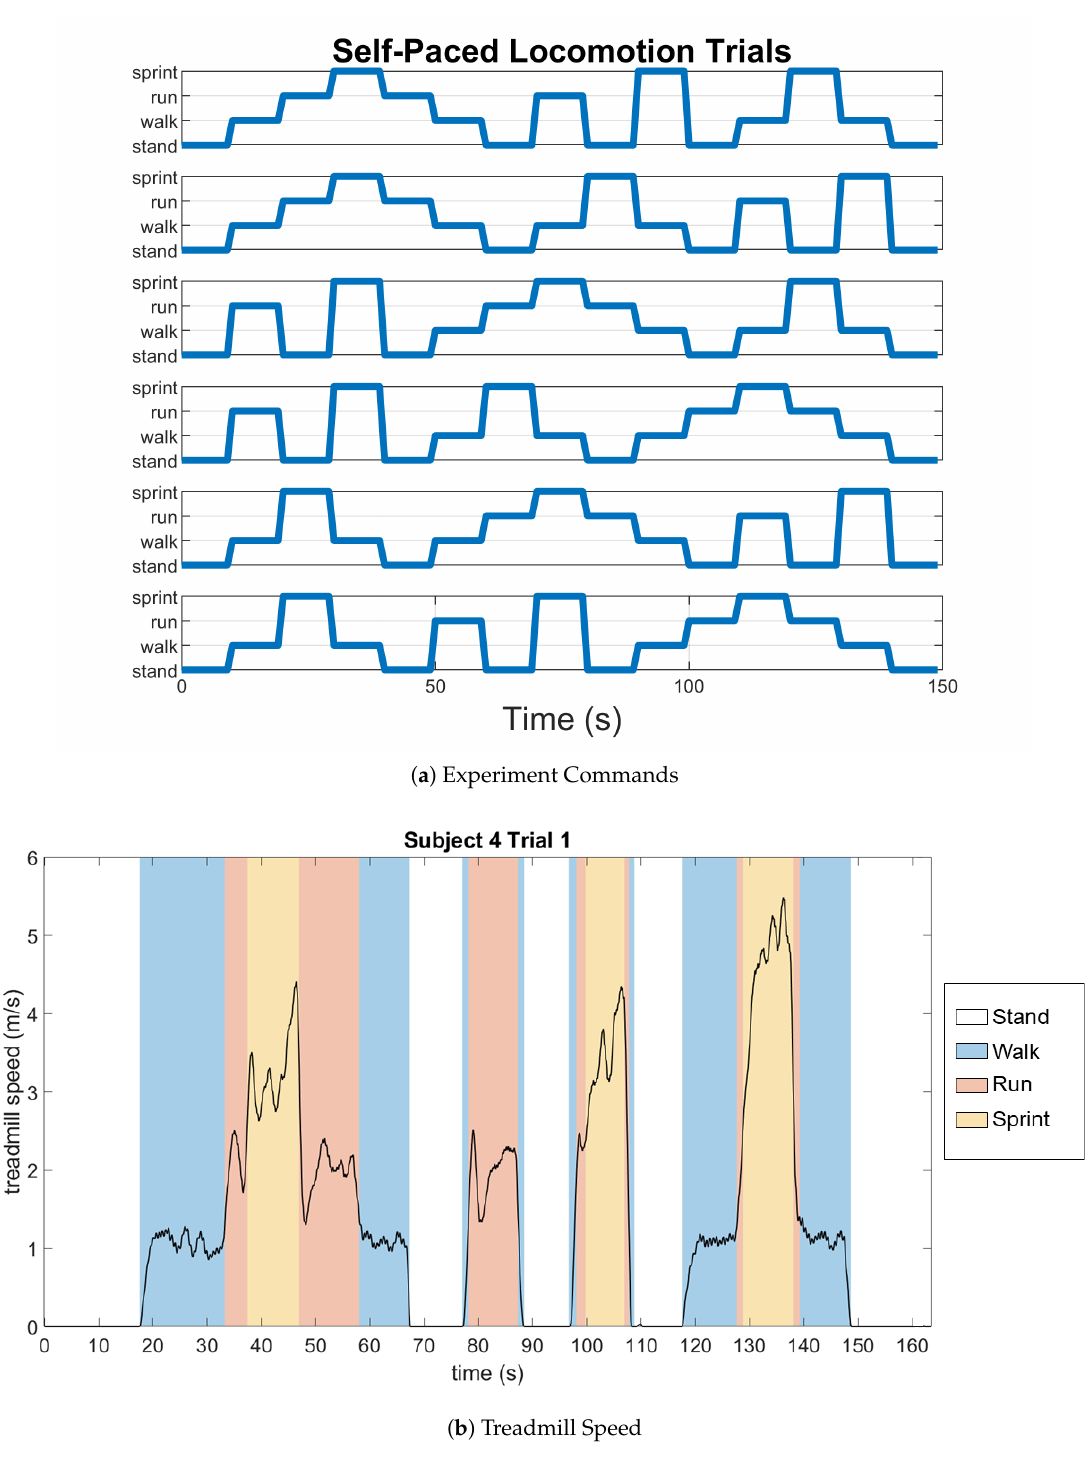
Figure 2. ( a ) The distribution of the commands each subject was given across time. There are six plots, one for each of the six trials. ( b ) Example of the self-paced treadmill speed for the first trial Subject 4 completed, where the commands are reflected in the speed at which the subject was moving. Note that while commands were given for the same duration, the activities are not all performed for the same duration, justifying the decision to label data points by speed instead of commanded